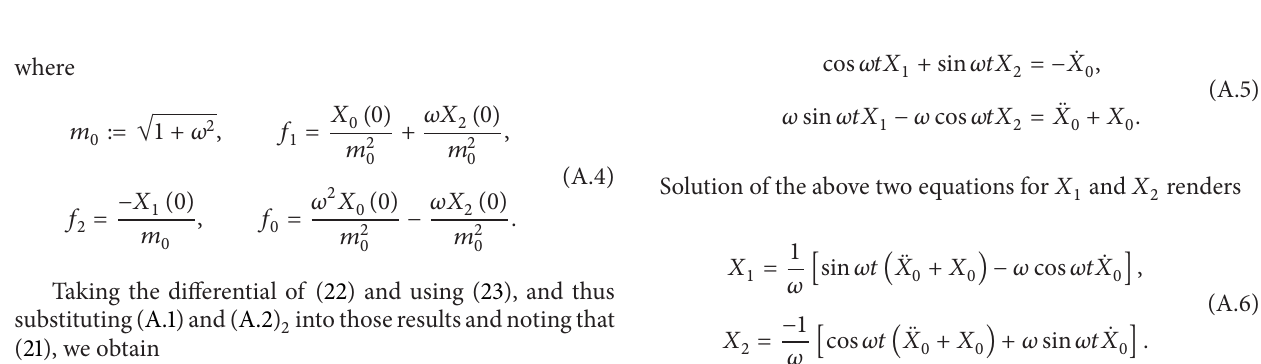
Figure 2: Component-wise errors of rotation matrix (a)–(i) and error of orthogonality (j) produced by the single-parameter method.